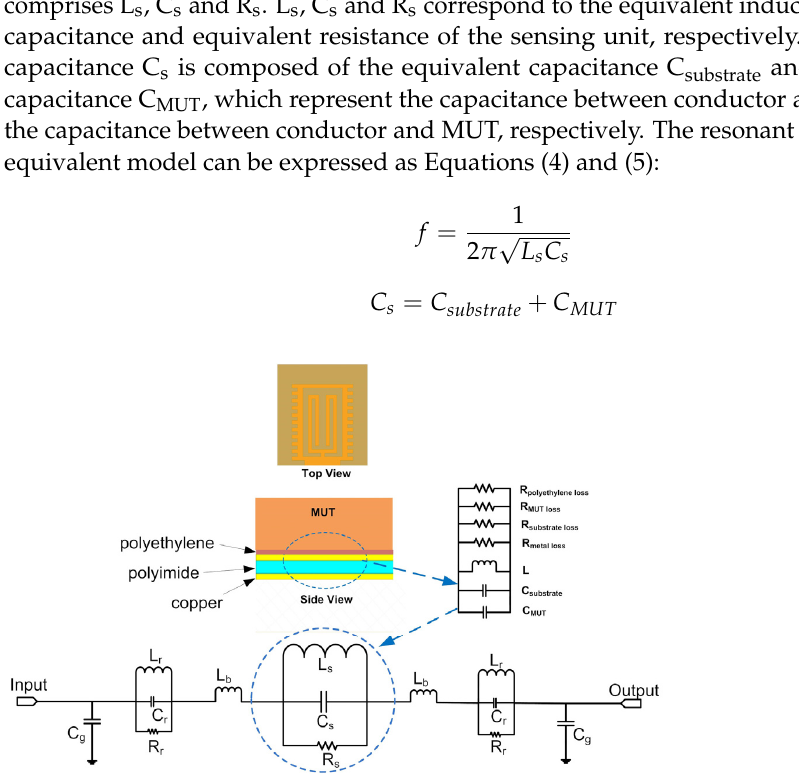
Figure 8. Equivalent circuit model of sensor.